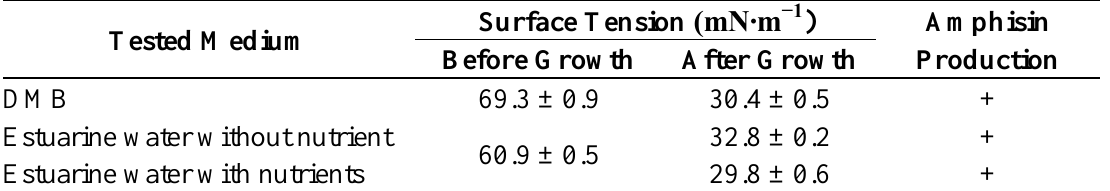
Table 2. Surface tension and associated standard deviations of P. fluorescens DSS73’s growth in estuarine water with or without nutrients. All experiments were performed in